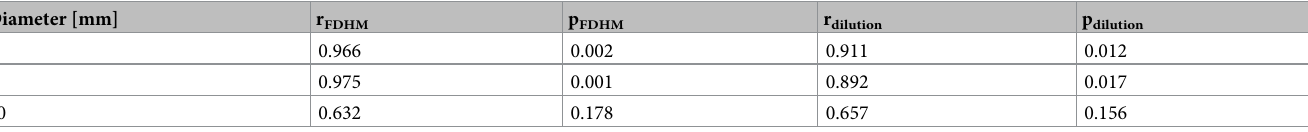
Table 2. Correlation factors of MPI-derived